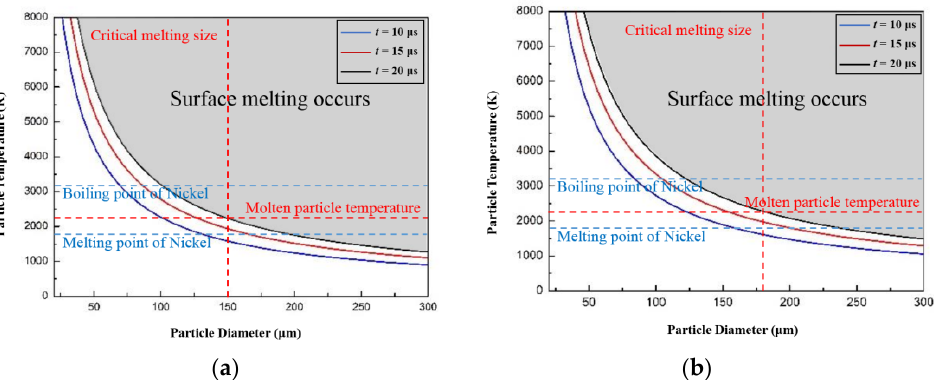
Figure 2. Surface melting criteria induced by the heat transfer of flattened particle: ( a ) 7075 substrate, ( b ) 304 substrate.